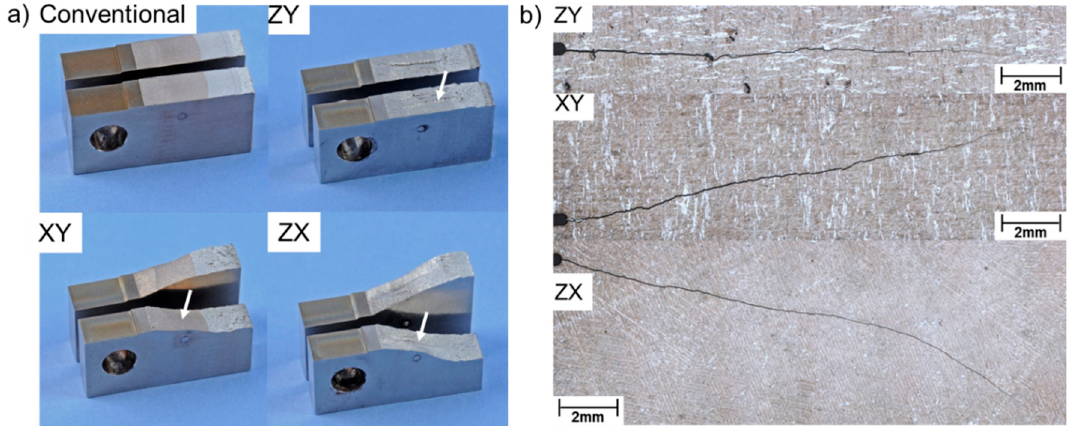
Figure 9. ( a ) Cracked compact tension (CT) specimens after FCG experiments and ( b ) longitudinal crack paths (before cracking of the specimens).